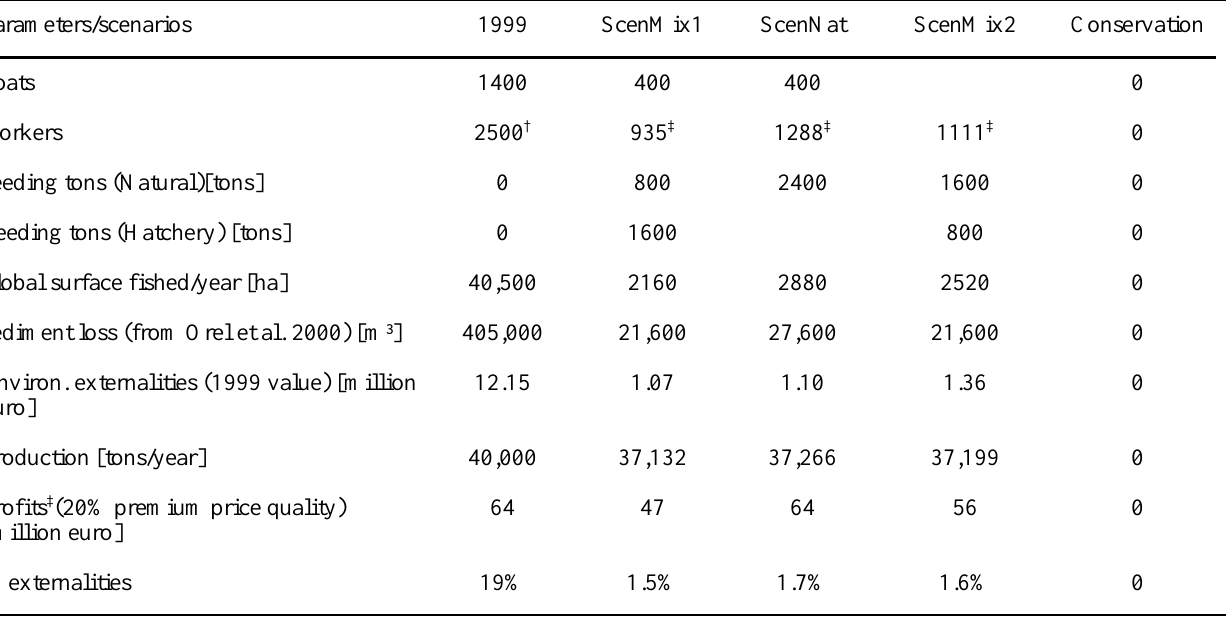
Table 9. Comparison among alternative clam exploitation scenario, as set by Figure 4. The extreme scenarios, represented by full exploitation scenario (data and estimates from 1999) and no exploitation scenario ( † data, ‡ estimates), are compared with three intermediate scenarios: ScenMix1, ScenNat, ScenMix2, assuming a revenue of 50,000 euro/year/worker. Surface and employments parameters have been set at first, productivity, revenue and externalities have been computed using modeling results.